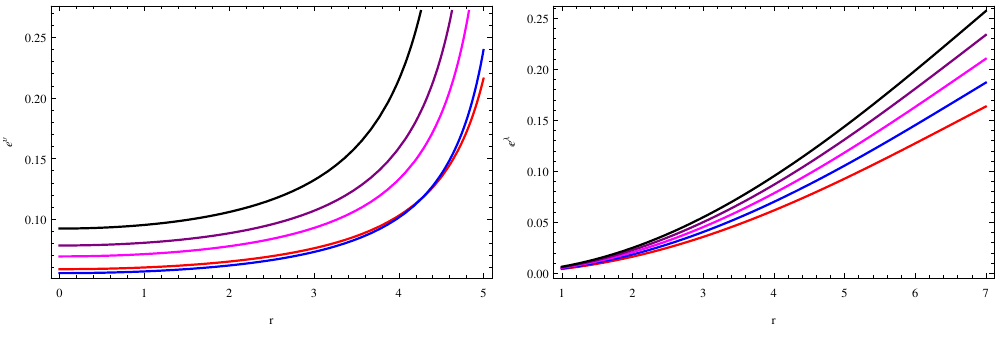
Figure 1. Plot of e ν ( r ) and e λ ( r ) versus r for the strange star candidate LMC X − 4. The red, purple, magenta, blue and black colors represent respectively cases (cid:118) = 0, (cid:118) = 0.5, (cid:118) = 1, (cid:118) = 1.5 and (cid:118) = 2.